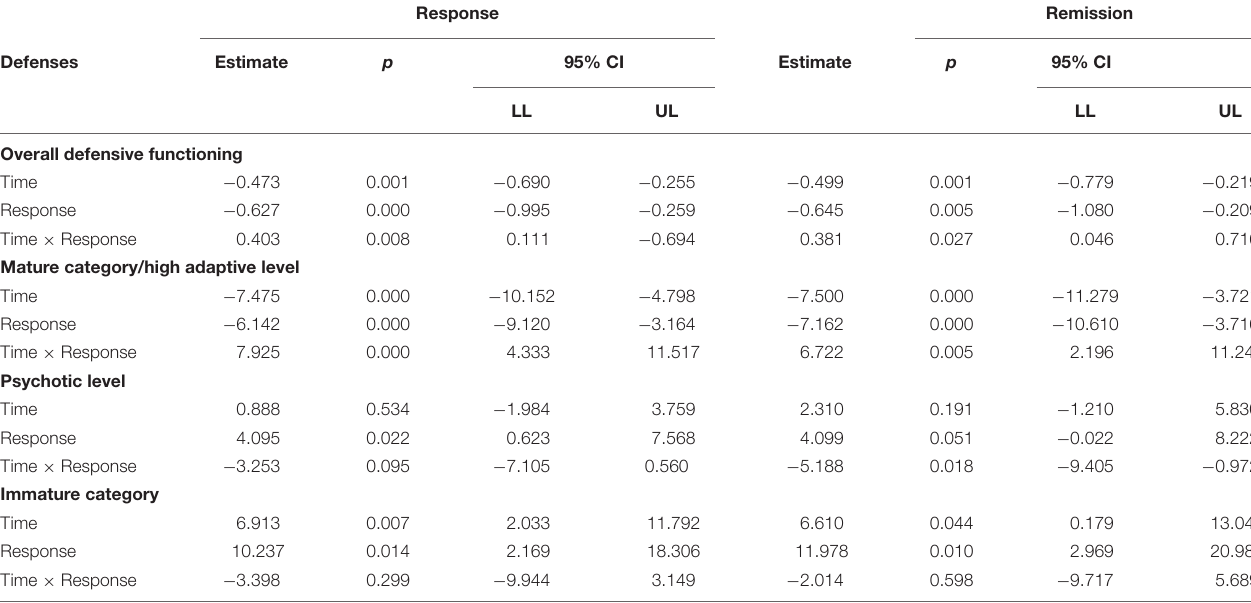
TABLE 4 | Relation among defenses and treatment response and remission after 12-month